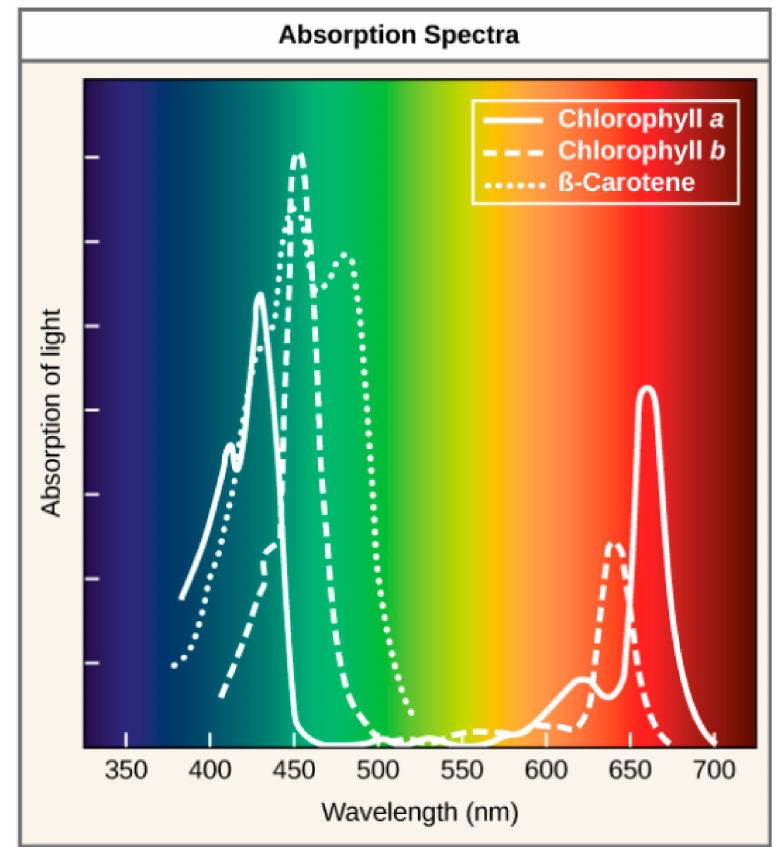
Figure 8. Light energy absorption in green plant tissues (for chlorophyll A—blue line and B—green line) in relation to light wavelengths [17]. From The Light-Dependent Reactions of Photosynthesis . In Biology 2e , by OpenStax: Houston, Texas, USA,